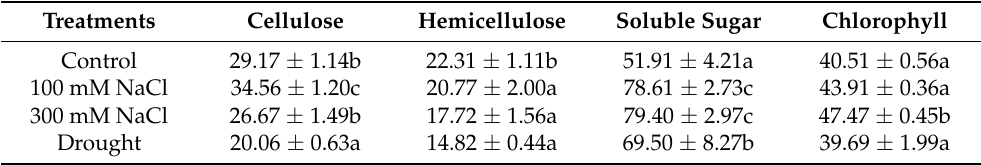
Table 2. Shoot cellulose (%), hemicellulose (%), total sugar (mg/g DW), and leaf chlorophyll (SPAD arbitrary values) of Phragmites karka under 0, 100, and 300 mM NaCl and drought. Values represent the mean ± S.E. of three replicates ( n = 4). Different lower-case letters indicate significant differences due to salt treatments, according to Bonferroni’s test ( p < 0.05). Treatments Cellulose